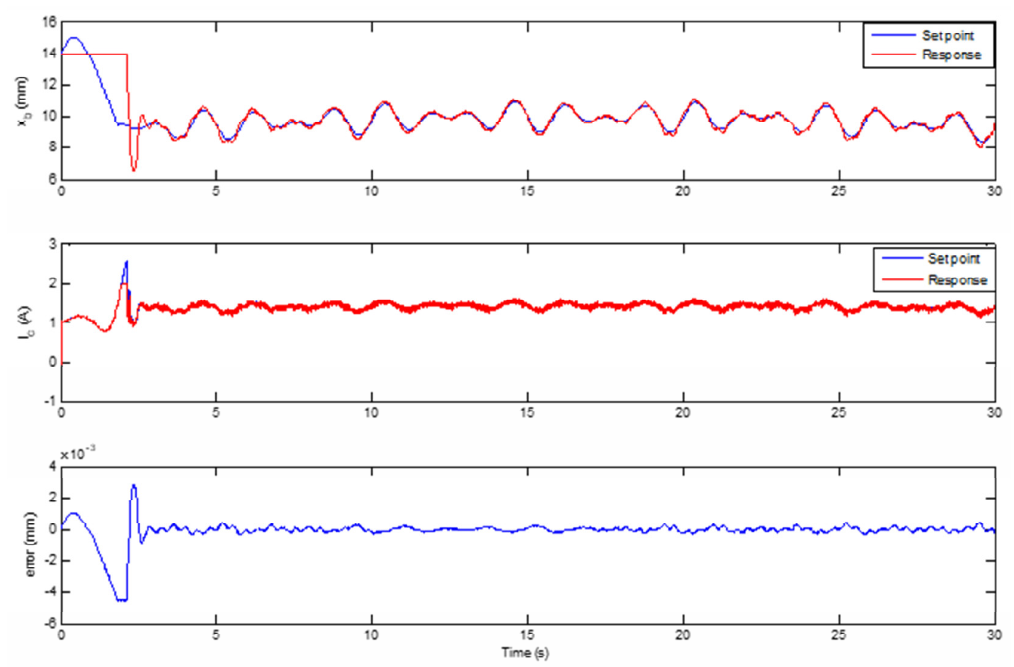
Figure 7. Multi-sine pattern—case 3 analysis.